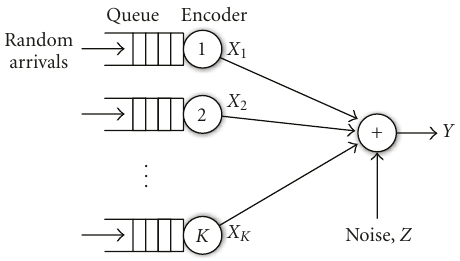
Figure 1: Gaussian multiple-access channel with random